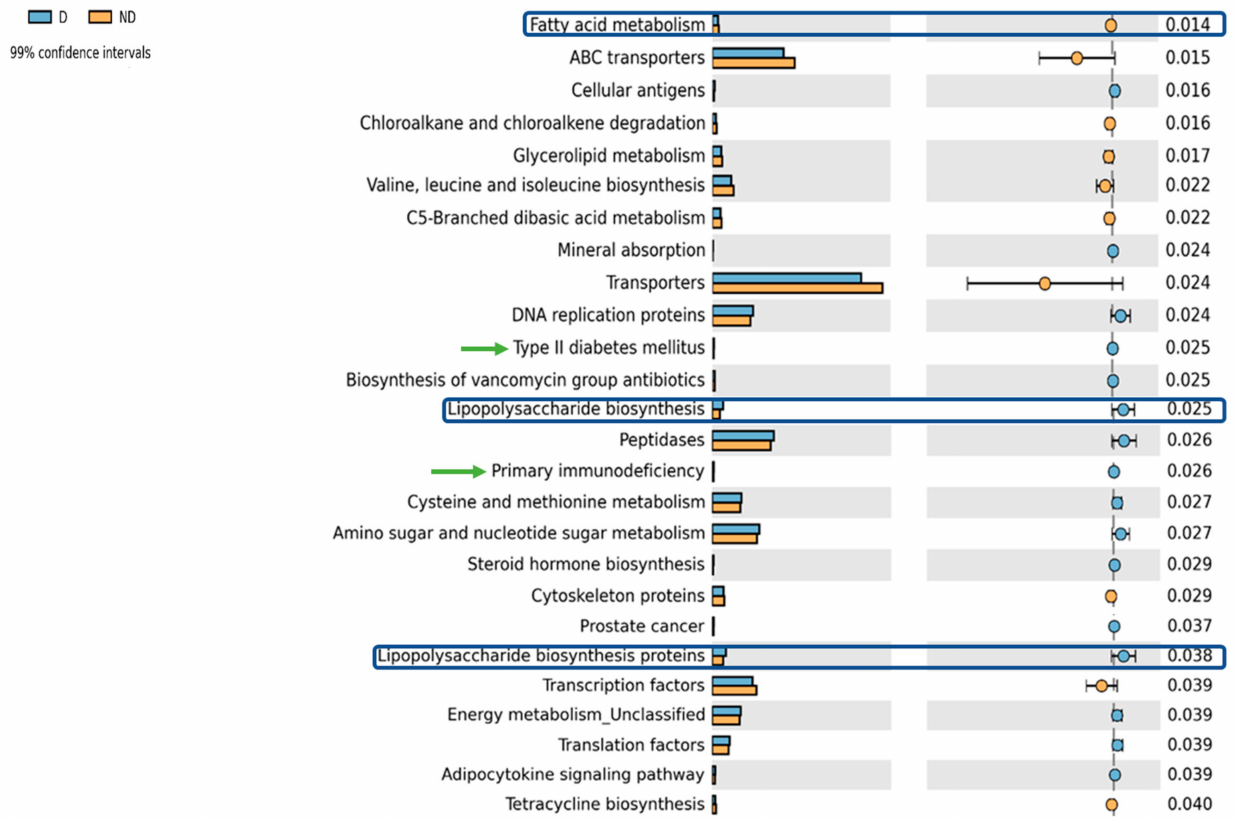
Figure 4. PICRUSt was used to infer gut microbiota functions using the 16S rRNA gene sequence data from vitamin D deficient (D) and non-deficient (ND) groups. The differences in projected functions of genes involved in fatty acid metabolism, as well as lipopolysaccharide biosynthesis and lipopolysaccharide biosynthesis proteins, are